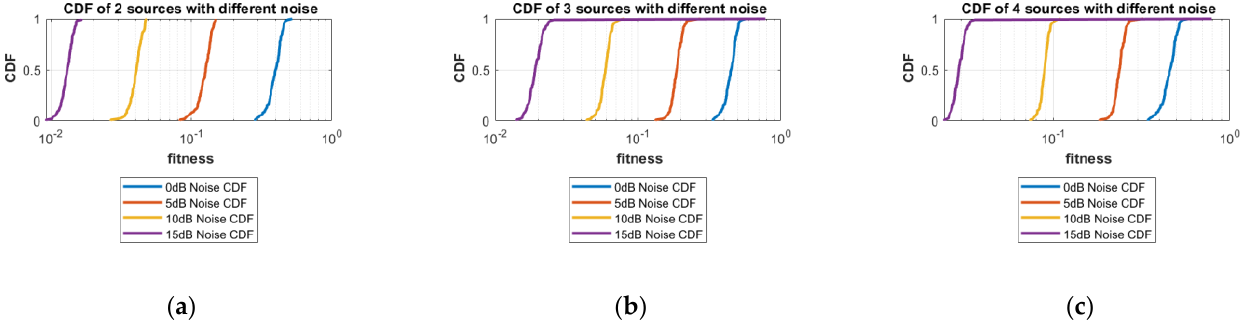
Figure 9. CDF with Different Noises: ( a ) Two Sources; ( b ) Three Sources; ( c ) Four Sources.